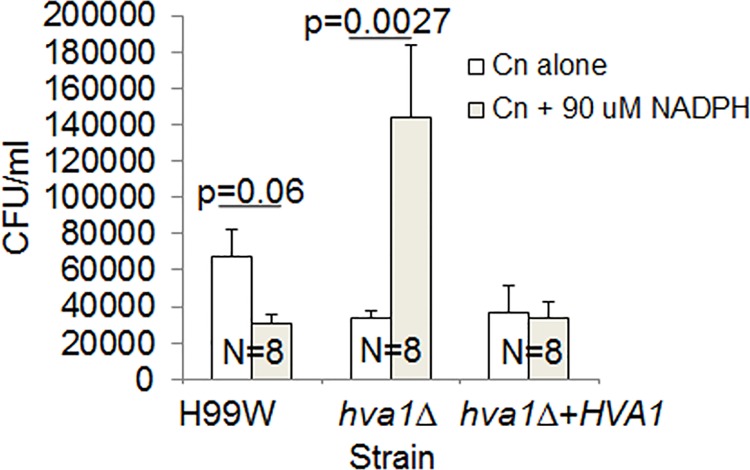
Fungal burden in RAW264.7 macrophages.The hva1Δ strain showed increased fungal burden in the presence of 90 μM NADPH. The graph is representative of three different experiments. Error bars depict the standard error of the mean. Numbers within bars represent the sample size for each strain/condition.